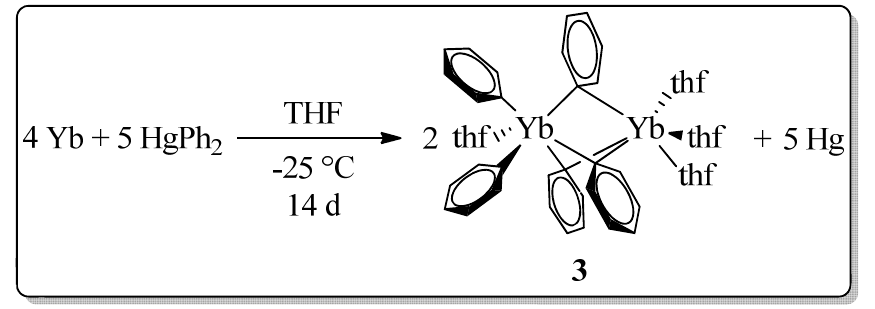
around the [Eu(thf) 7 ] 2+ cation with one BPh 4 − and one THF molecule removed for clarity. Aver-